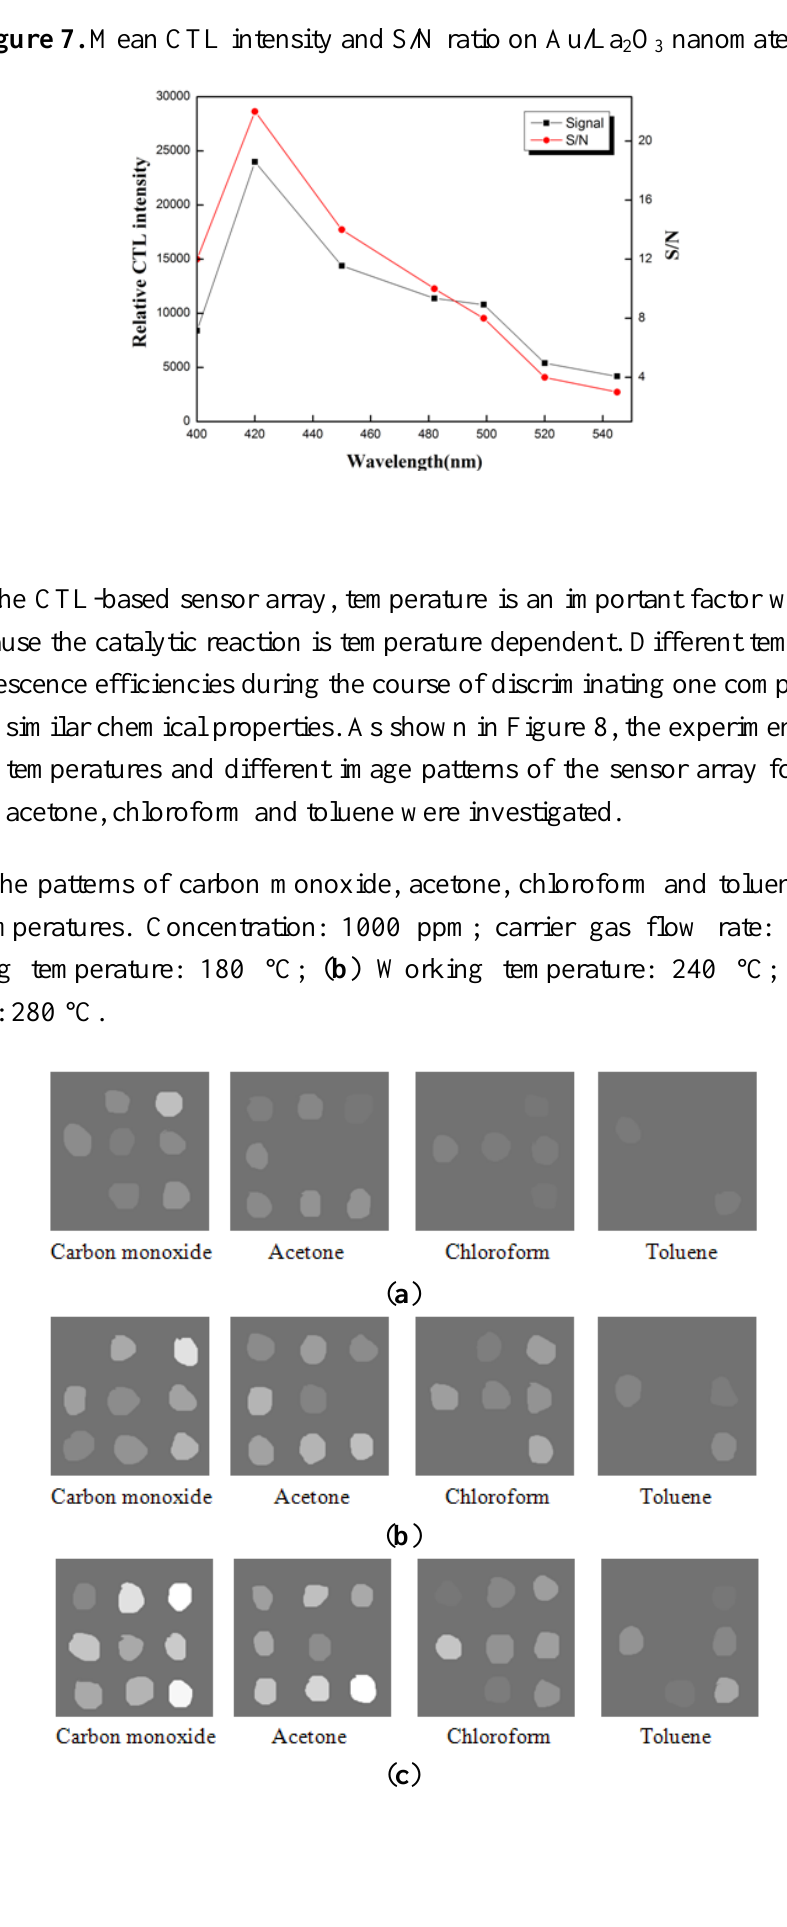
Figure 7. Mean CTL intensity and S/N ratio on Au/La